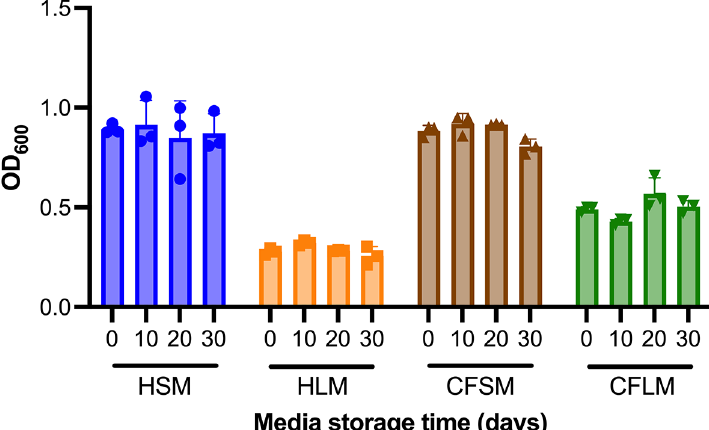
Figure 5. Stability of biofilm formation in developed media stored for up to 30 days. Media suitability for supporting biofilm growth of PAO1 was determined using CV stain assays performed in media that had been stored at 4 ° C for up to 30 days. Each timepoint is one biological replicate representing the average of three technical replicates. Statistical analysis was undertaken using Graph pad Prism 8.0. Statistical analysis: Two-way ANOVA, no statistically significant differences were found between fresh media and media stored for up to 30